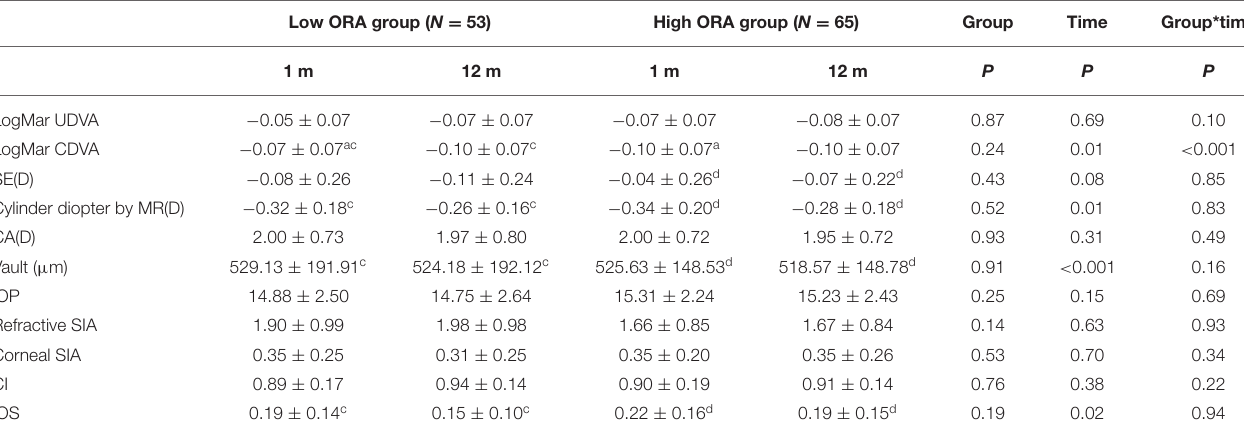
TABLE 2 | Postoperative comparison of low ORA group and high ORA group. Low ORA group ( N = 53) High ORA group ( N = 65) Group Time